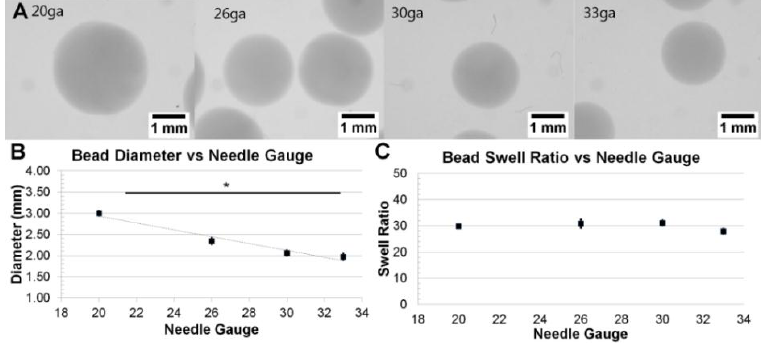
Figure 1. Fibrin Beads Formation: ( A ) Schematic showing fibrin bead formation. Alginate (black) will immediately cross-linking due to the presence of Ca 2+ . Over time, thrombin in the cross-link solution will diffuse into the bead, cleaving fibrinogen to fibrin (grey), allowing for self-polymerization. These beads are then incubated in SADS to chelate the Ca 2+ , dissolving the alginate and leaving a fibrin bead scaffold; ( B ) Representative bright-field images of fibrin beads formed with 20 ga and 33 ga needle.